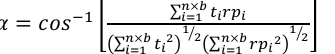
Fig.2 Supervised classification diagram